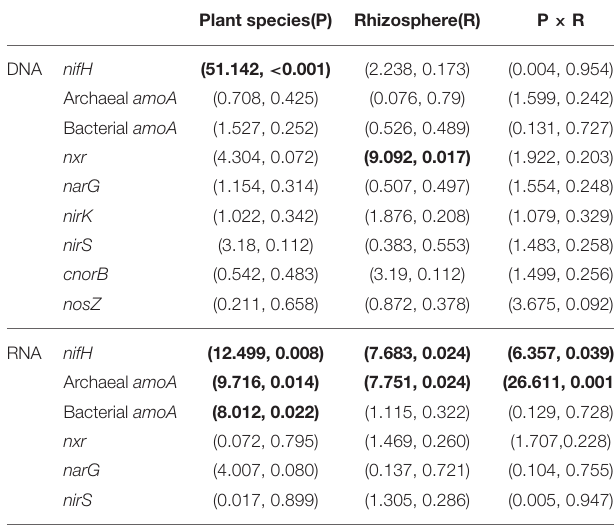
TABLE 4 | The rates of nitrogen fixation (NFR), nitrification (NR) and denitrificaton (DNR) in bulk tailings and rhizospheric samples of plant species; lowercase letters indicate significant differences in each column (LSD, P < 0.05).